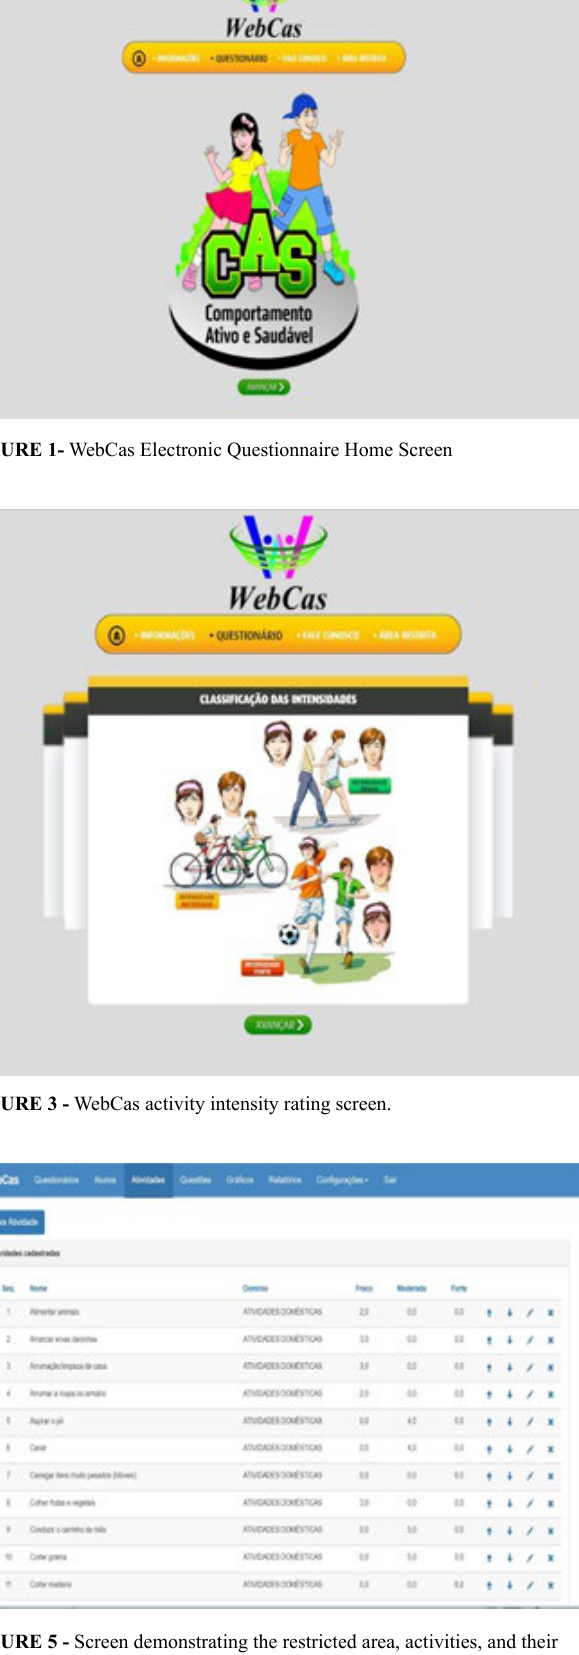
FIGURE 6 - Restricted area demo screen for WebCas questions